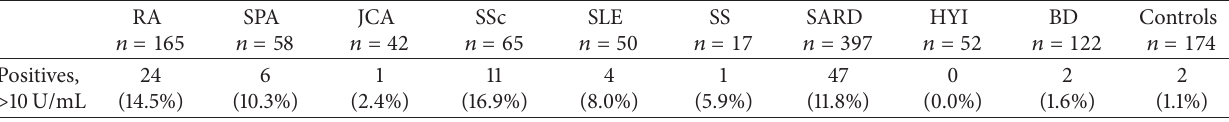
Table 2: Prevalence of anti-hnRNP B1 autoantibodies in sera of 397 patients with systemic autoimmune rheumatic diseases and 174 controls.